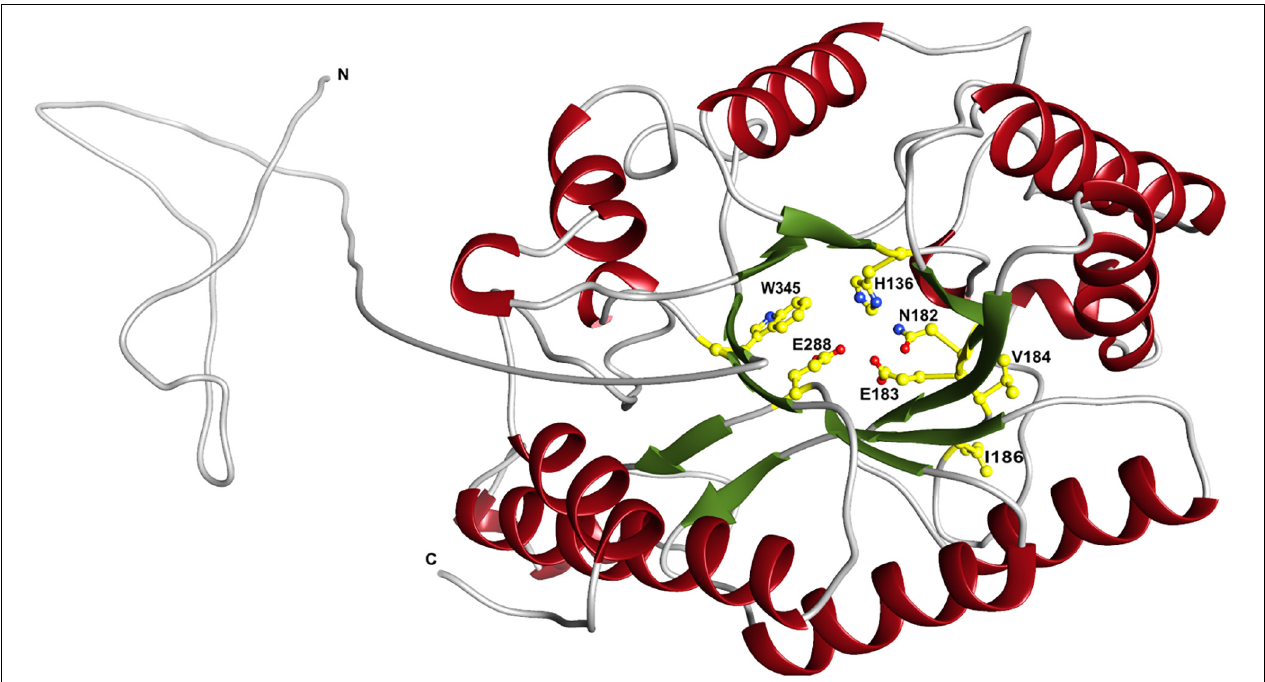
FIGURE 7 | Schematic representation of the modeled XynDZ5 3D structure. The XynDZ5 3D structure was modeled using Phyre-2 presenting the secondary structural elements of the enzyme. The predicted catalytic dyad, E183 and E288, as well as the residues His136, N182, and W345 lying at the predicted active site are shown in ball-and-stick representation. α -helices and β -sheets are shown in red and green, respectively. In gray are the coiled areas and a non-modeled structure connected via a linker with the main enzyme. N and C are the N- and C- termini, respectively. The figure was prepared using UCSF Chimera (Pettersen et al.,